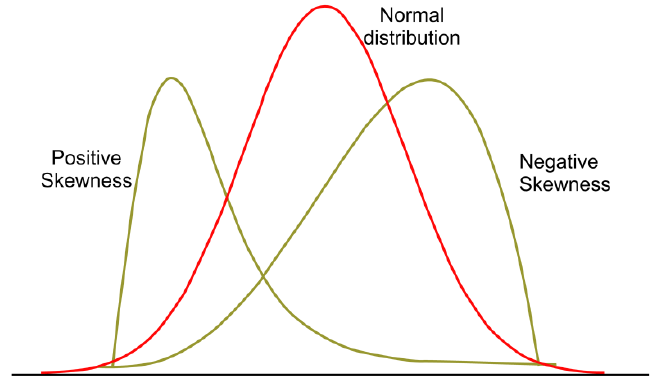
Figure 5. Shape of skewness.